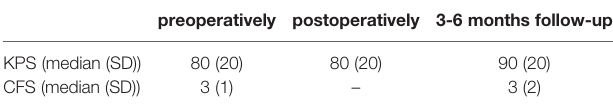
TABLE 2 | Median pre- and postoperative as well as follow-up values for KPS and CFS, including IqR, are